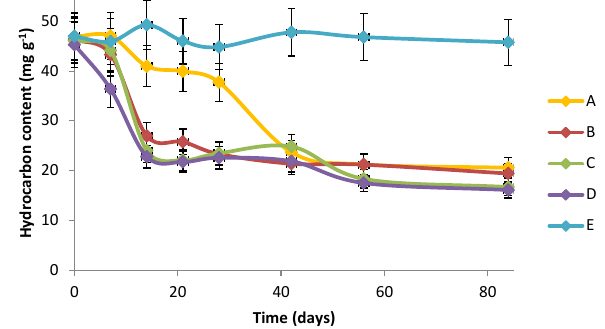
Figure 2. Changes of hydrocarbon content in remediated soil (A – soil that was moistened and aerated, B – soil that was moistened, aerated, and amended with 1% biochar, C – soil that was moistened, aerated, and amended with 1% biochar with P. aeroginosa , D – soil that was moistened, aerated, and amended with 1% biochar with A. radioresistens , E – soil without treatment).